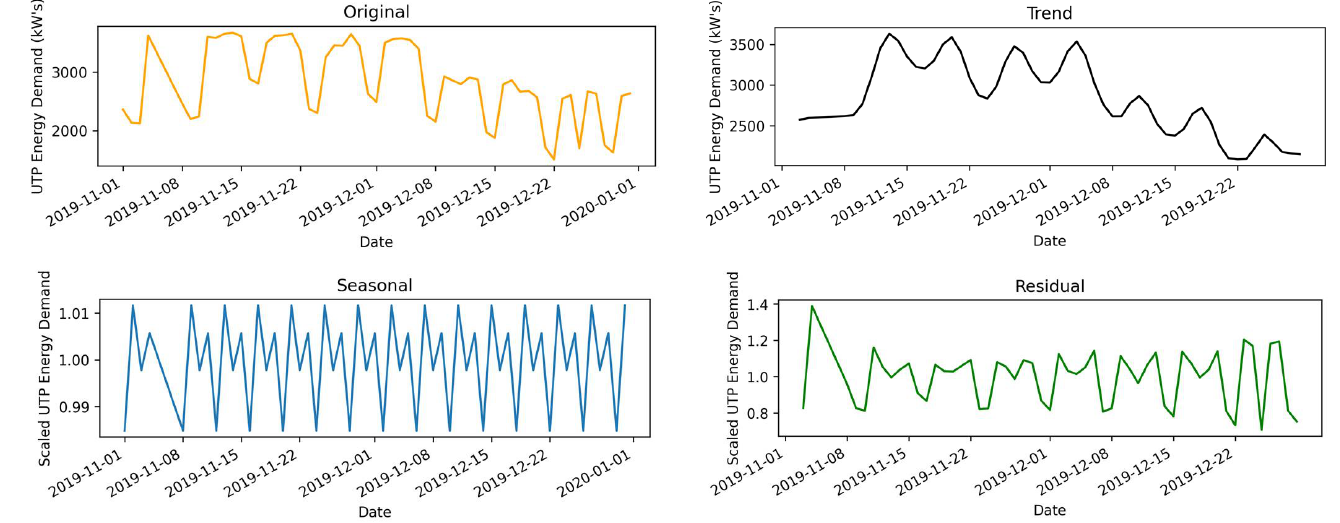
Figure 8. U.T.P. original and decomposed data for November and December 2019.